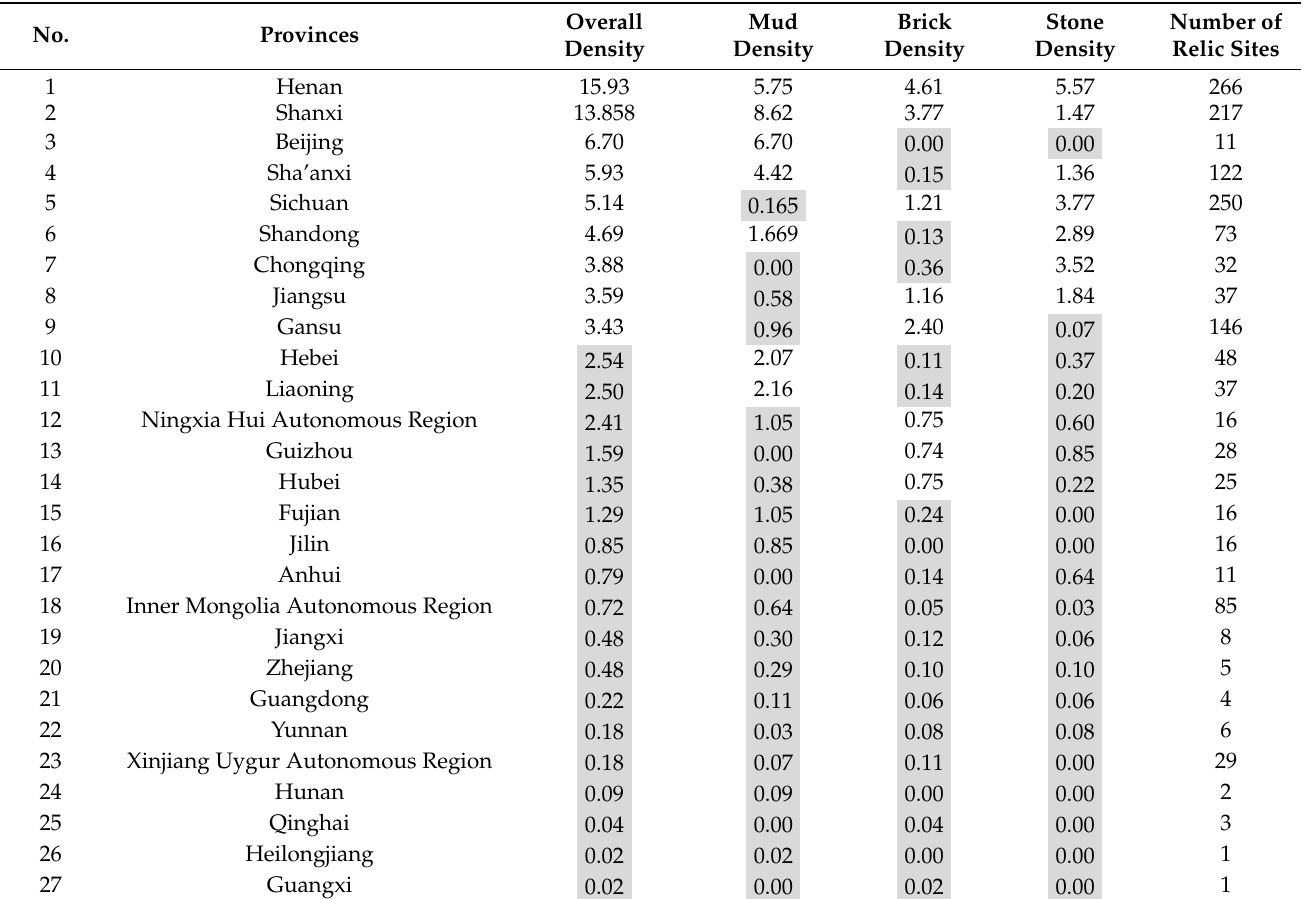
Table 3. Distribution density of the types of Chinese tomb